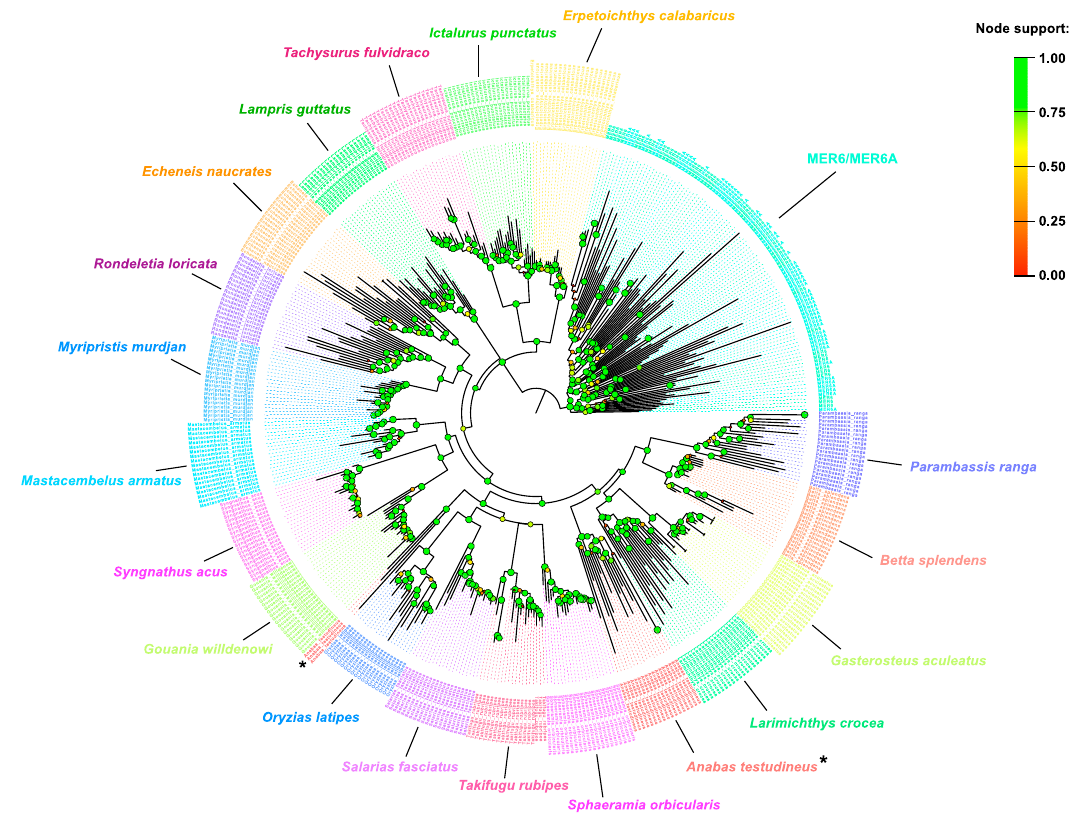
Figure 4. Maximum likelihood tree calculated on 477 bony fish V-SINE sequences and MER6 elements, using the Jukes–Cantor + CAT model. Coloured dots at nodes indicate the support value, as per upper-right legend. The name of fish species from which V-SINEs have been isolated are also reported near the relative cluster. Asterisks mark non-monophyletic Anabas testudineus Ac1-like SINEs.